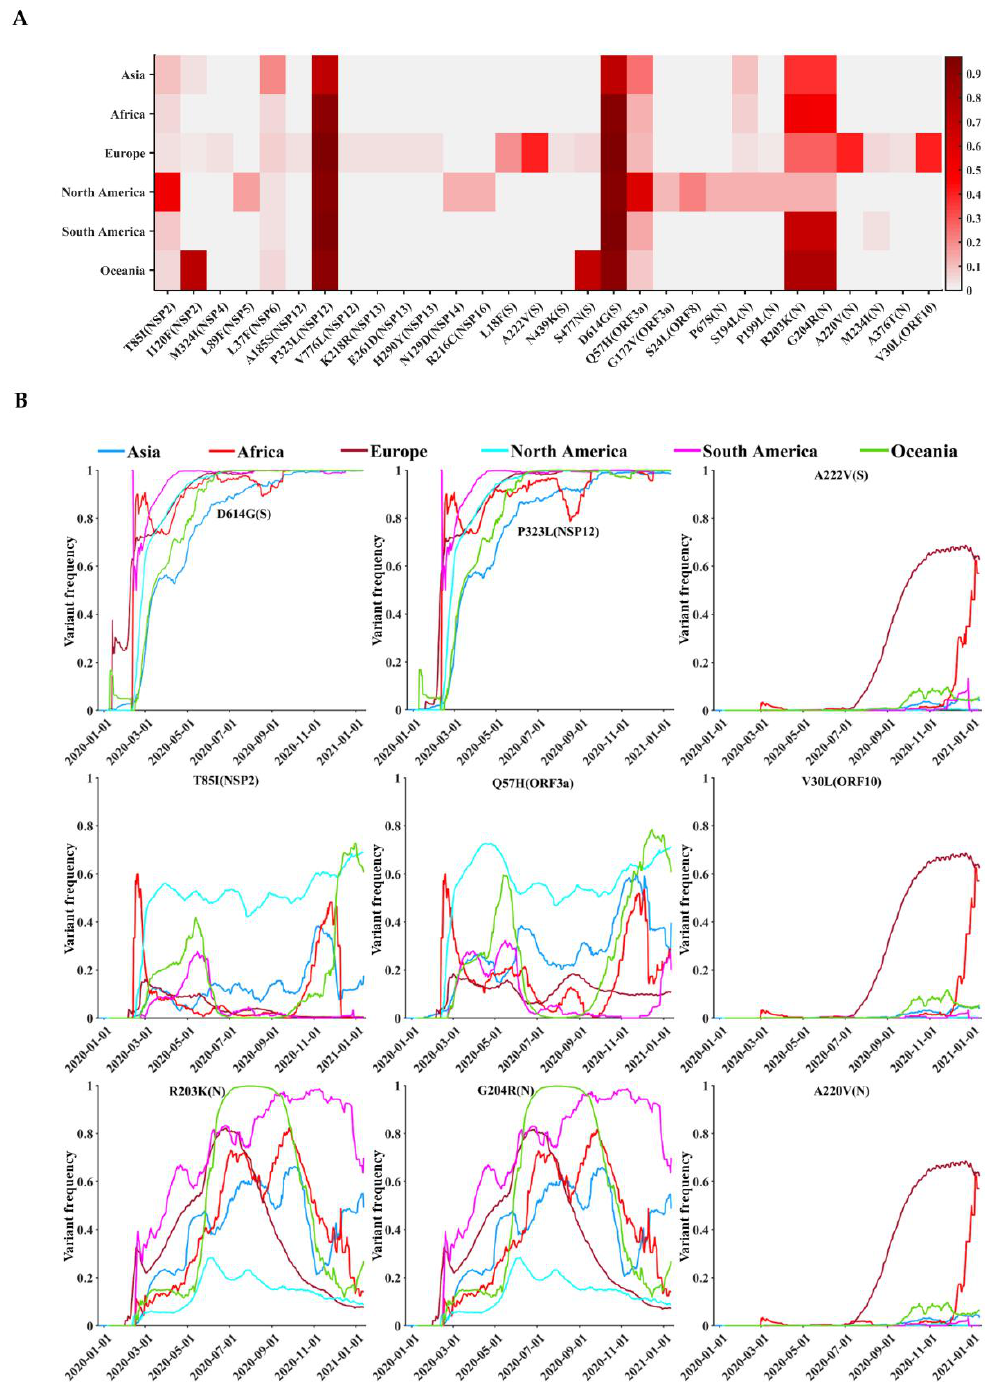
Figure 4. Distribution of frequent variants across the SARS-CoV-2 proteins in different geographic areas. ( A ) Frequencies of the top 30 variants, with the highest variant frequencies in different continents. ( B ) Temporal and geographic dynamics of frequent SARS-CoV-2 variants. The vertical axis represents the moving-window variant frequency calculated by dividing the number of sequences containing a specific variant, 15 days before and after a specific date, by the total number of sequences in the period (31 days).